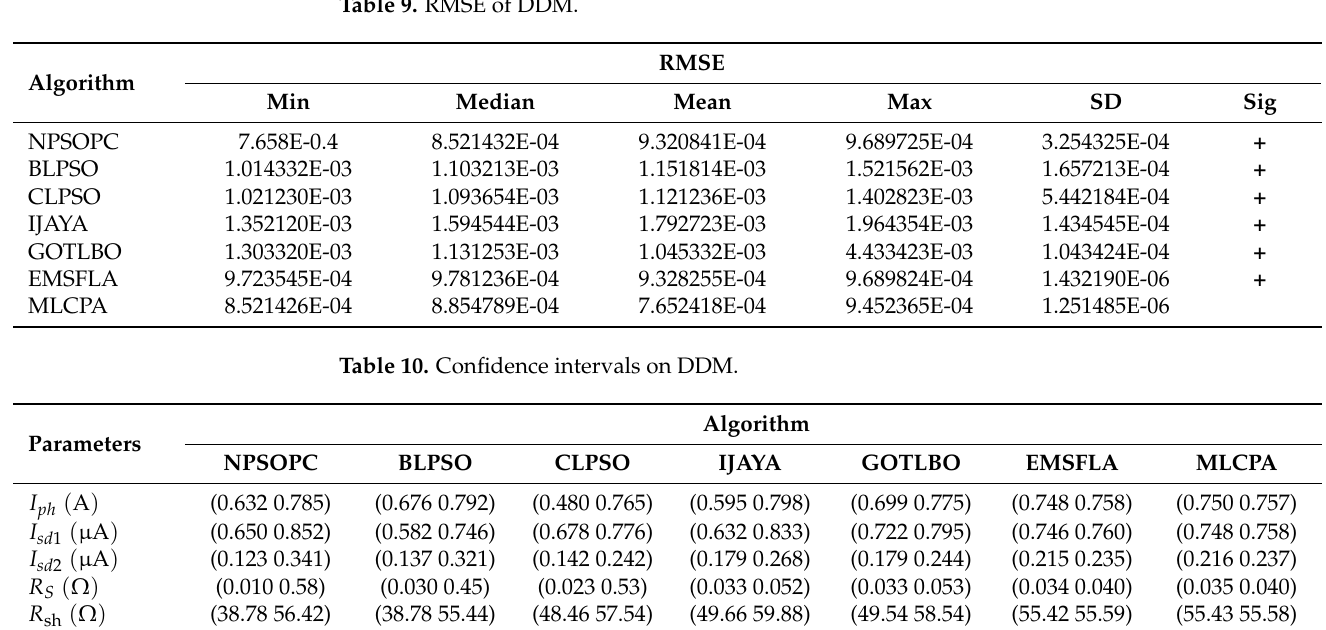
Table 9. RMSE of DDM.